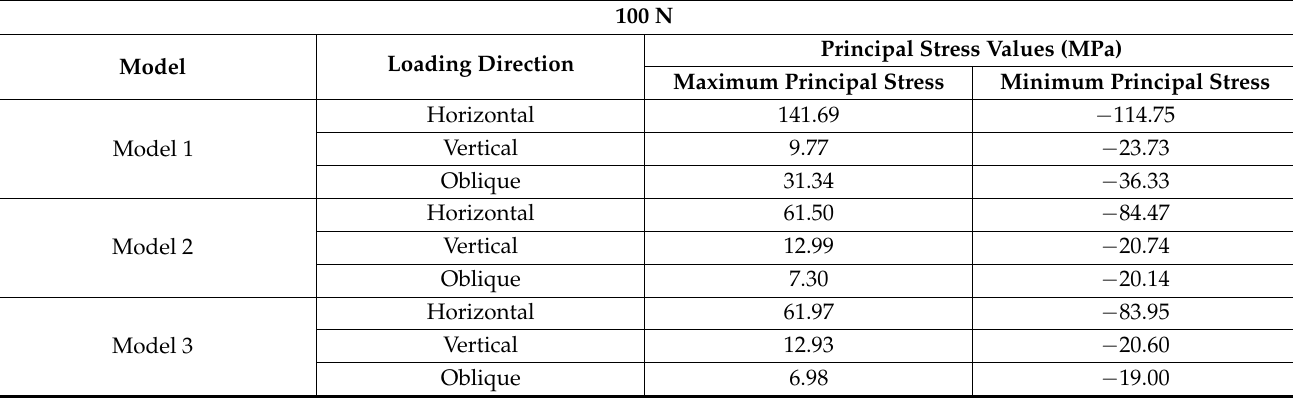
Table 4. The Maximum and Minimum Principal Stress values on the bone tissue after 100 N of horizontal, vertical and oblique